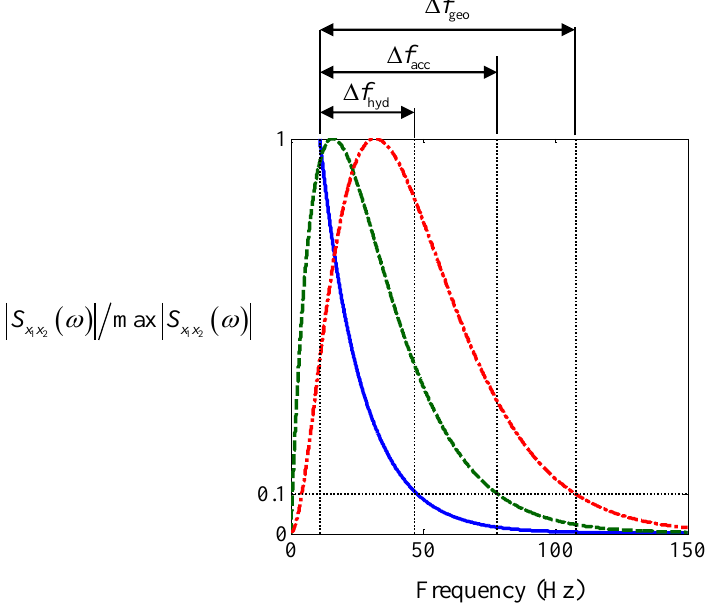
max S  is the x x 1 2